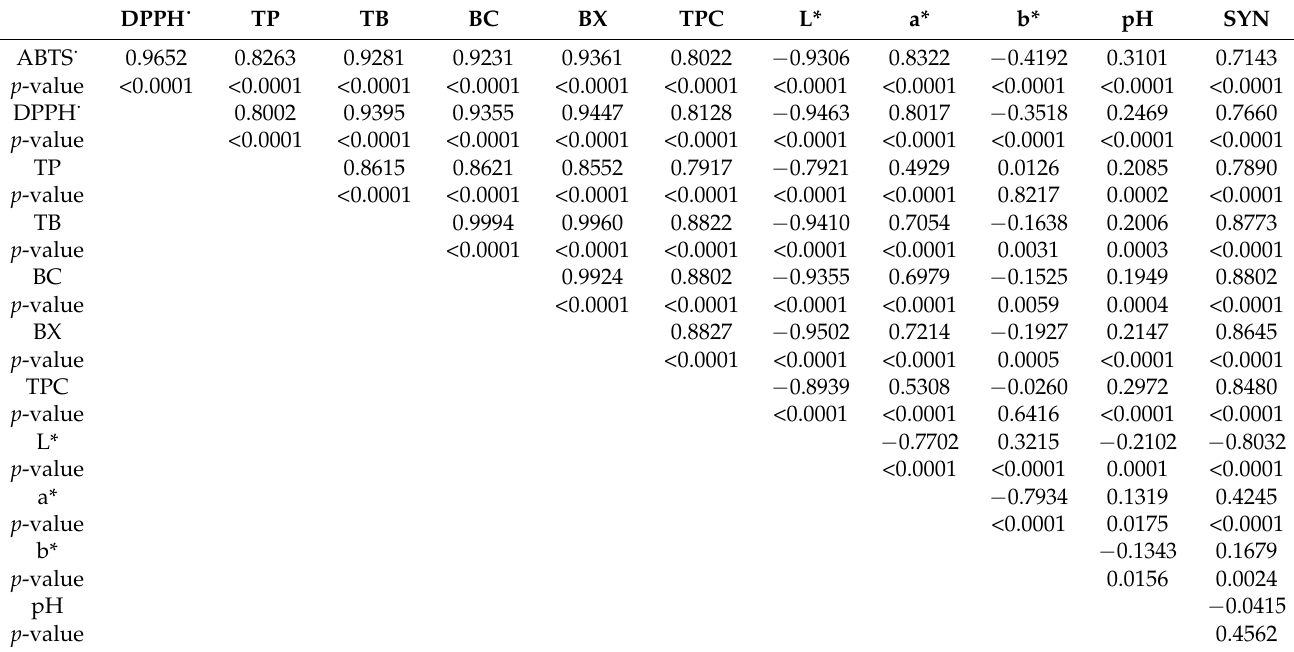
Table 3. Correlation between the response variables of yogurt added with liquid extract and freeze-dried beet extracts ( Beta vulgaris